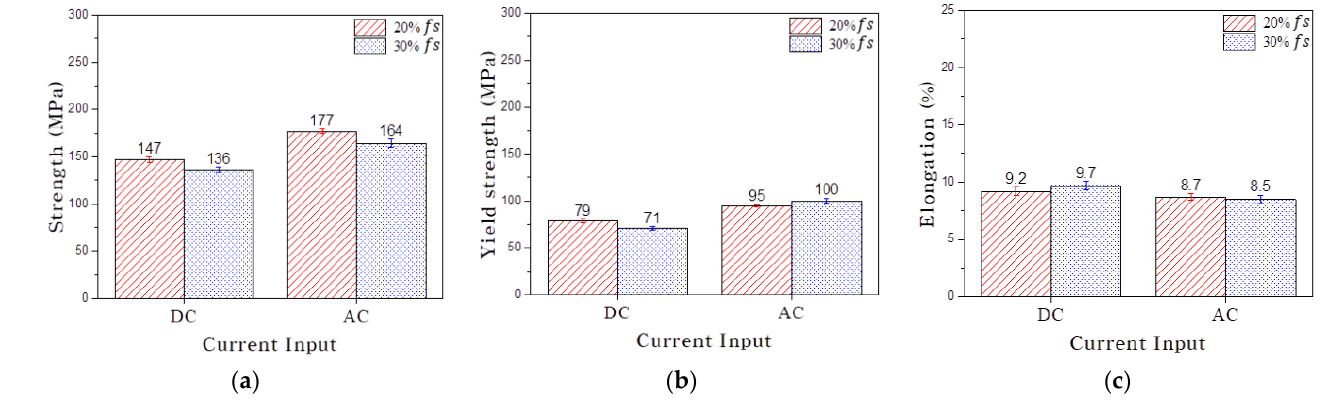
Figure 7. Mechanical properties according to the current input method and solid fraction: ( a ) ultimate tensile strength, ( b ) yield strength, and ( c ) elongation.